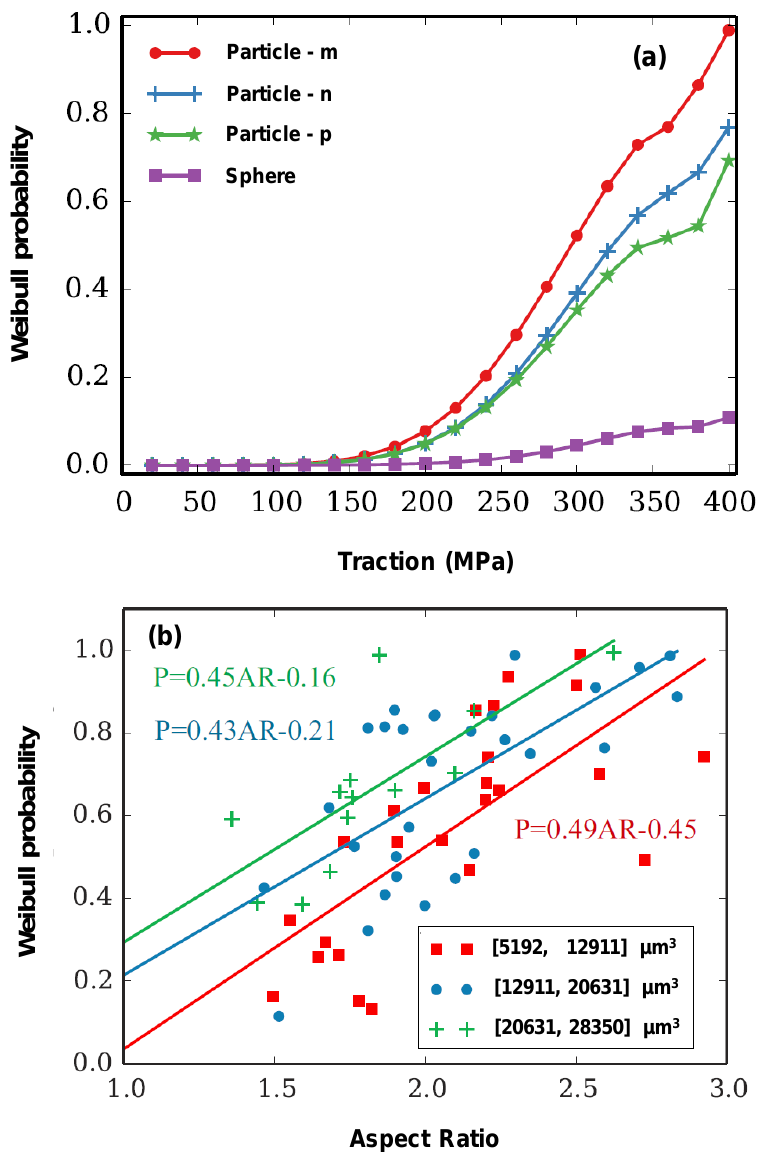
Figure 11. Characteristic study of the influence of particle geometry on the magnitude of Weibull fracture probability ( a ) history plot of fracture probability, ( b ) fracture probability vs. aspect ratio.